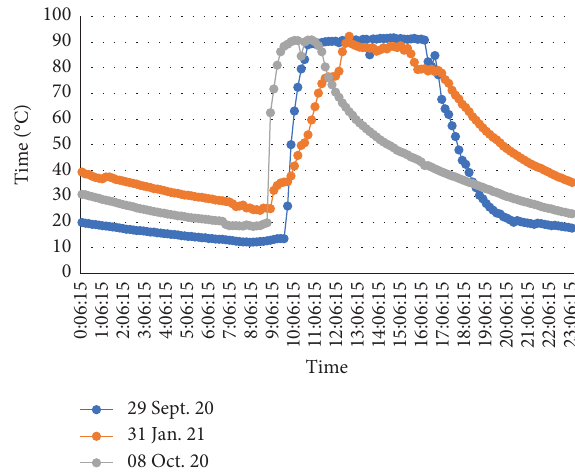
Figure 8: Evaporator SW temperature on various days under moderate average solar